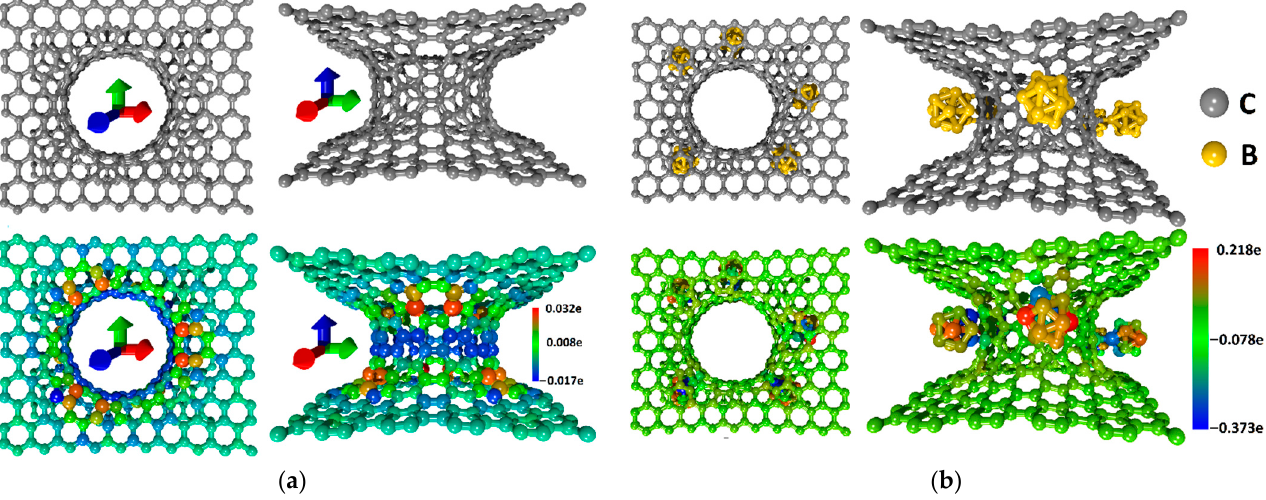
Figure 1. The PGR/B 12 composite supercell. ( a ) The supercell of the pure PGR and the charge distribution over atoms in the XY and ZY planes; ( b ) the supercell of PGR with five boron clusters and the charge distribution over atoms in the XY and ZY planes. Red indicates a lack of electrons; blue indicates an excess of electrons.